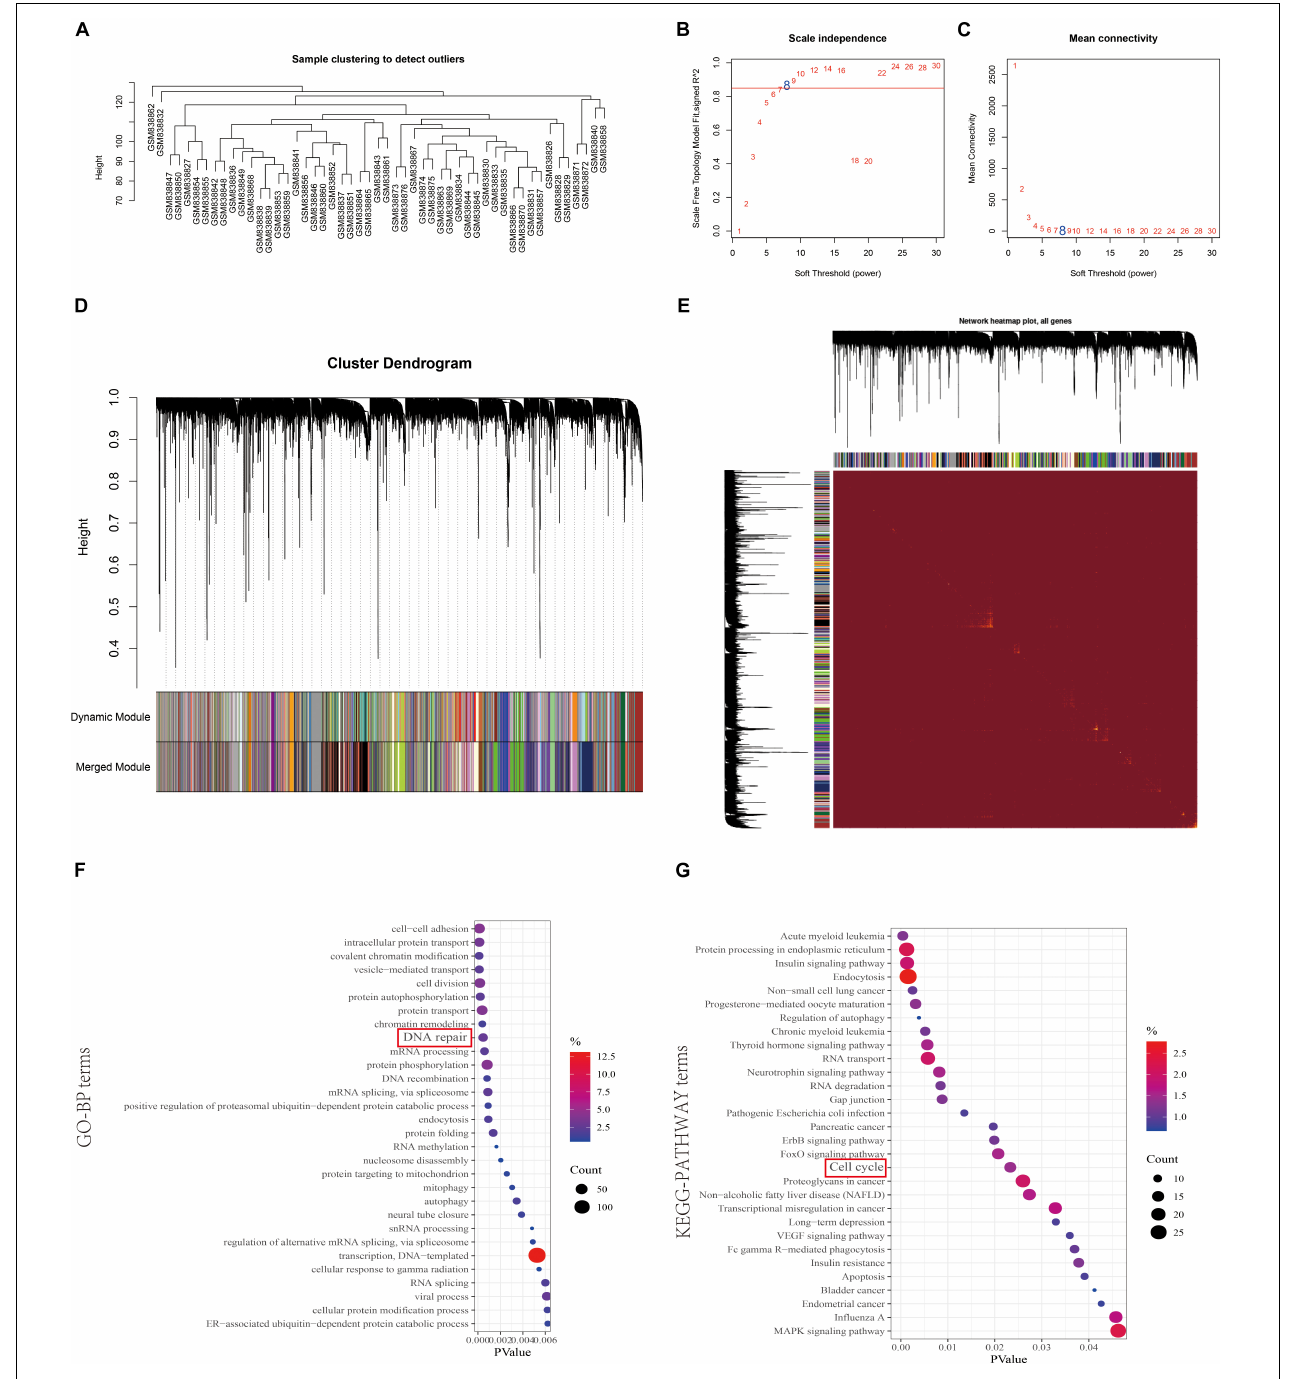
FIGURE 6 | Identification of coexpression module genes associated with SAE1 using the WGCNA. (A) Clustering dendrogram of TNBC tissues. (B) Relationship between scale-free topology model fit and soft thresholds (powers). (C) Relationship between the mean connectivity and various soft thresholds. (D) Dendrogram of modules identified by WGCNA. (E) Topological overlap matrix among detected genes from RNAseq. (F,G) GO-BP (F) and KEGG pathway (G) network for the target genes in green model.